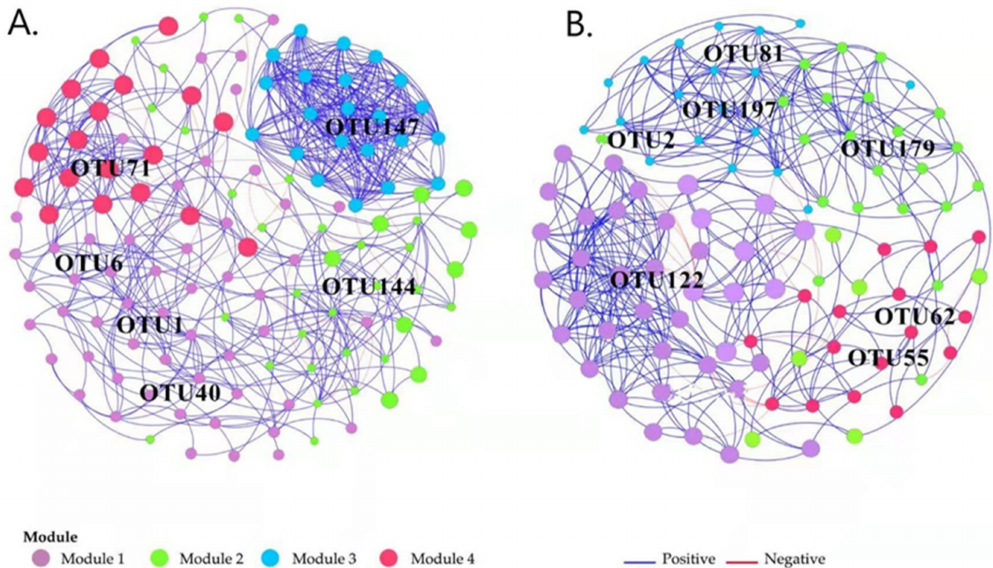
Figure 6. Network analysis of ( A ) amoA -AOA and ( B ) amoA -AOB OTUs modules. Modules consist of four clusters which are closely interconnected nodes. The node’s size is relative to the degree and the thickness is proportional to the value of correlation coefficients. Keystone taxa OTUs are labeled in the networks based on betweenness of centrality. Only OTUs with a relative abundance greater than 0.01 percent are used in the